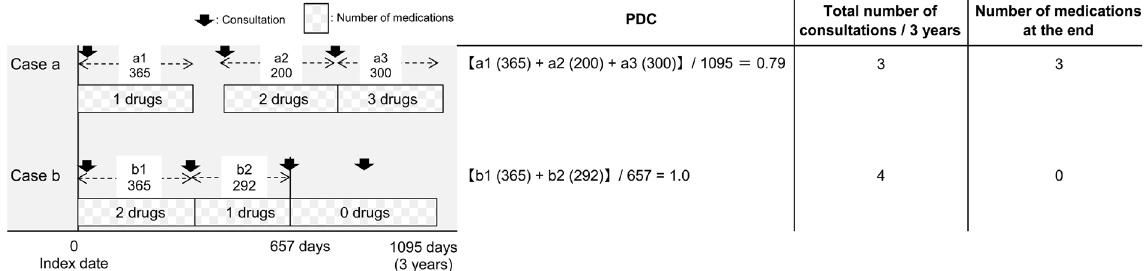
Figure 2. Proportion of days covered (PDC) based on the total number of consultations in 3 years and the number of medications at the end of the observation period. Case a: The prescription days of a1, a2 and a3 were added, and PDC was determined by dividing the number by 1095 days of the observation period. The number of drugs at the end of observation period corresponds to the number of drugs prescribed in a3. Case b: Since the medication use was completed at the third (b2) and subsequent consultations, the observation period for medication adherence was 657 days.The prescription days of b1 and b2 were added, and PDC was determined by dividing the number by 657 days of the observation period. The number of drugs at the end of observation period corresponds to the number of drugs prescribed in b3. Thus, the number of drugs at the end of the observation period is